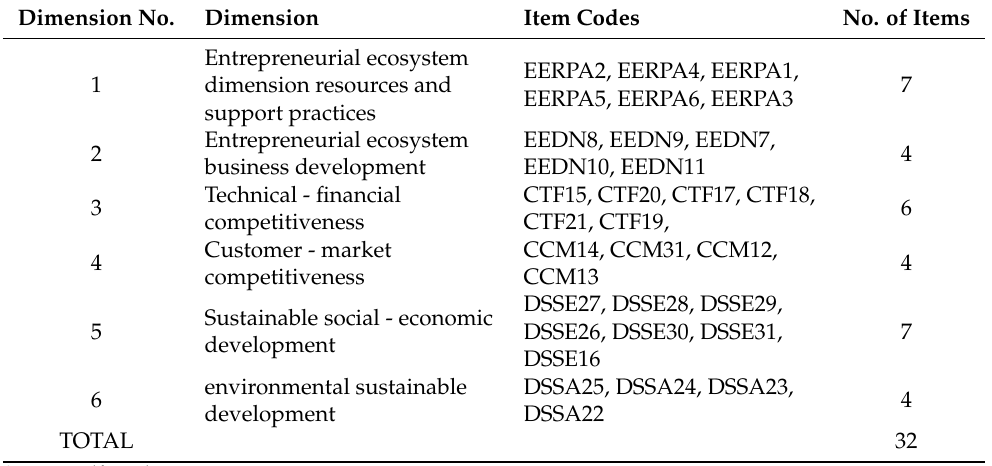
Table 1. This is a table caption. Tables should be placed in the main text near to the first time they are